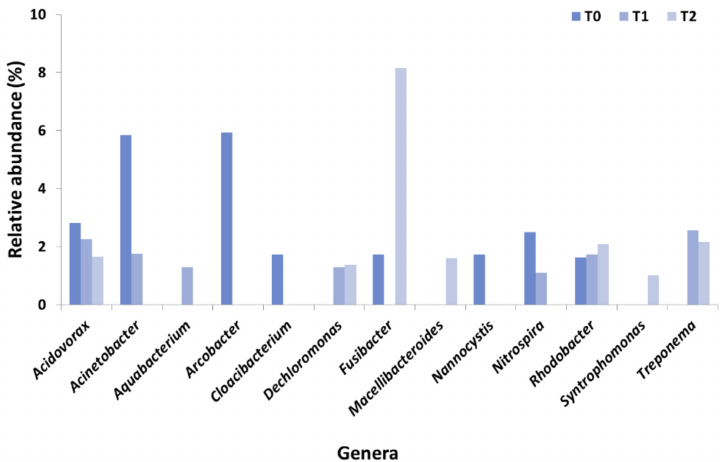
Figure 12. Relative abundance of the most abundant (i.e., having percentage values > 1) bacterial genera identified by NGS analysis of the V3–V4 region of the 16S rRNA encoding gene in the activated sludge of T0, T1 and T2 conditions, respectively.